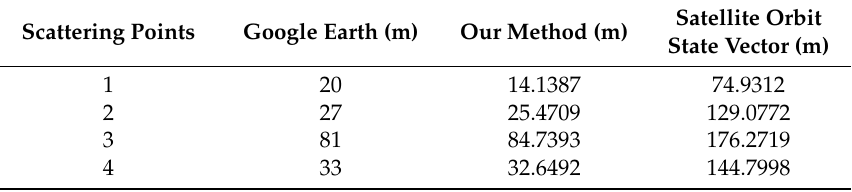
Table 3. Results of the checking